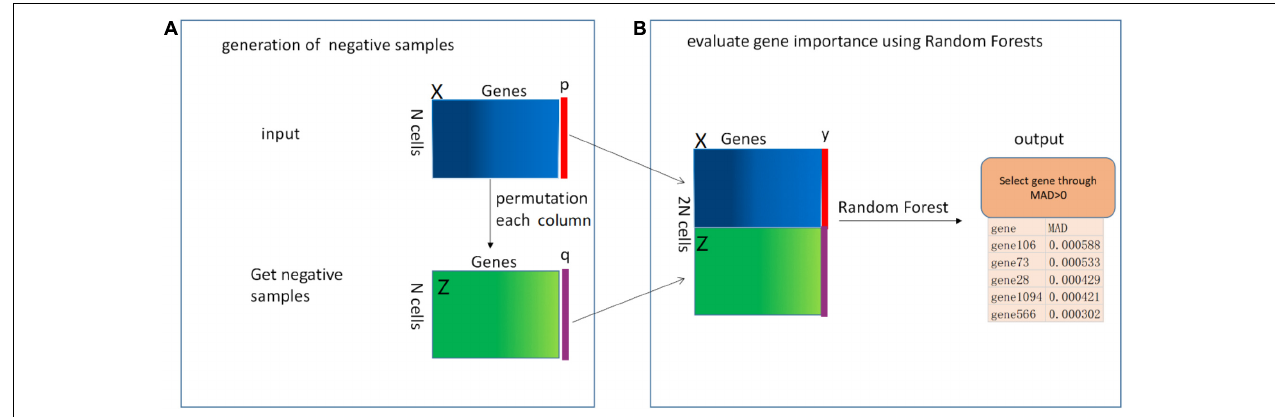
FIGURE 1 | The mechanism of RFCell (scRNA-seq gene selection based on permutation and Random Forest) algorithm. The input is a gene expression matrix. The RFCell algorithm includes two steps: (A) Generation of negative samples; (B) Evaluation of gene importance using Random Forest.